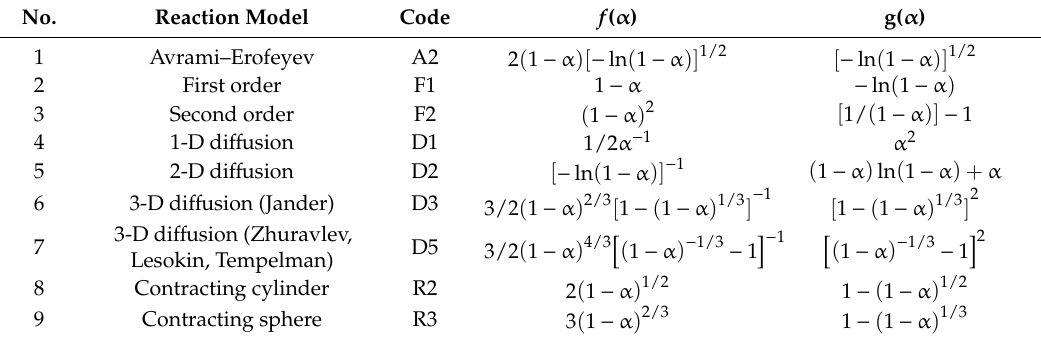
Table 1. Some of the kinetic models used in calculation of kinetic of depolymerization.